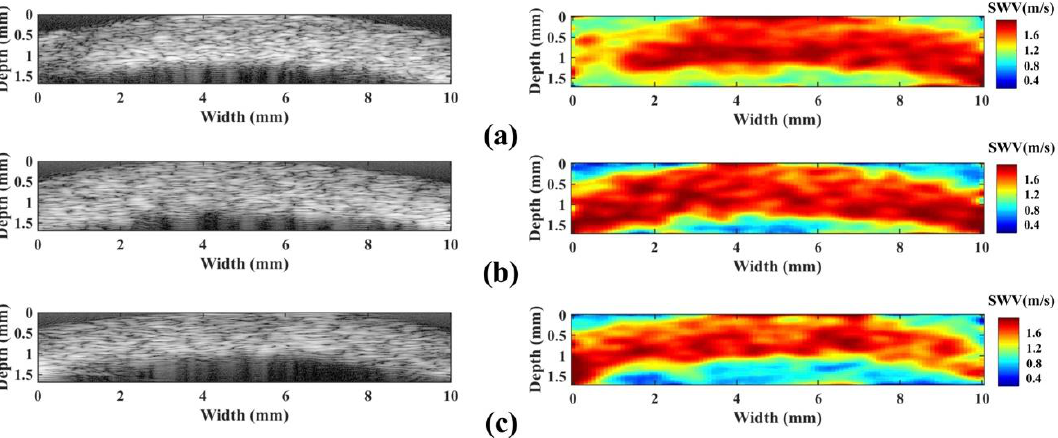
Figure 6 . B-mode images and their corresponding HR-SWI images of the human corneas from three donors ( a – c ). Left: B-mode images. Right: SWI images.